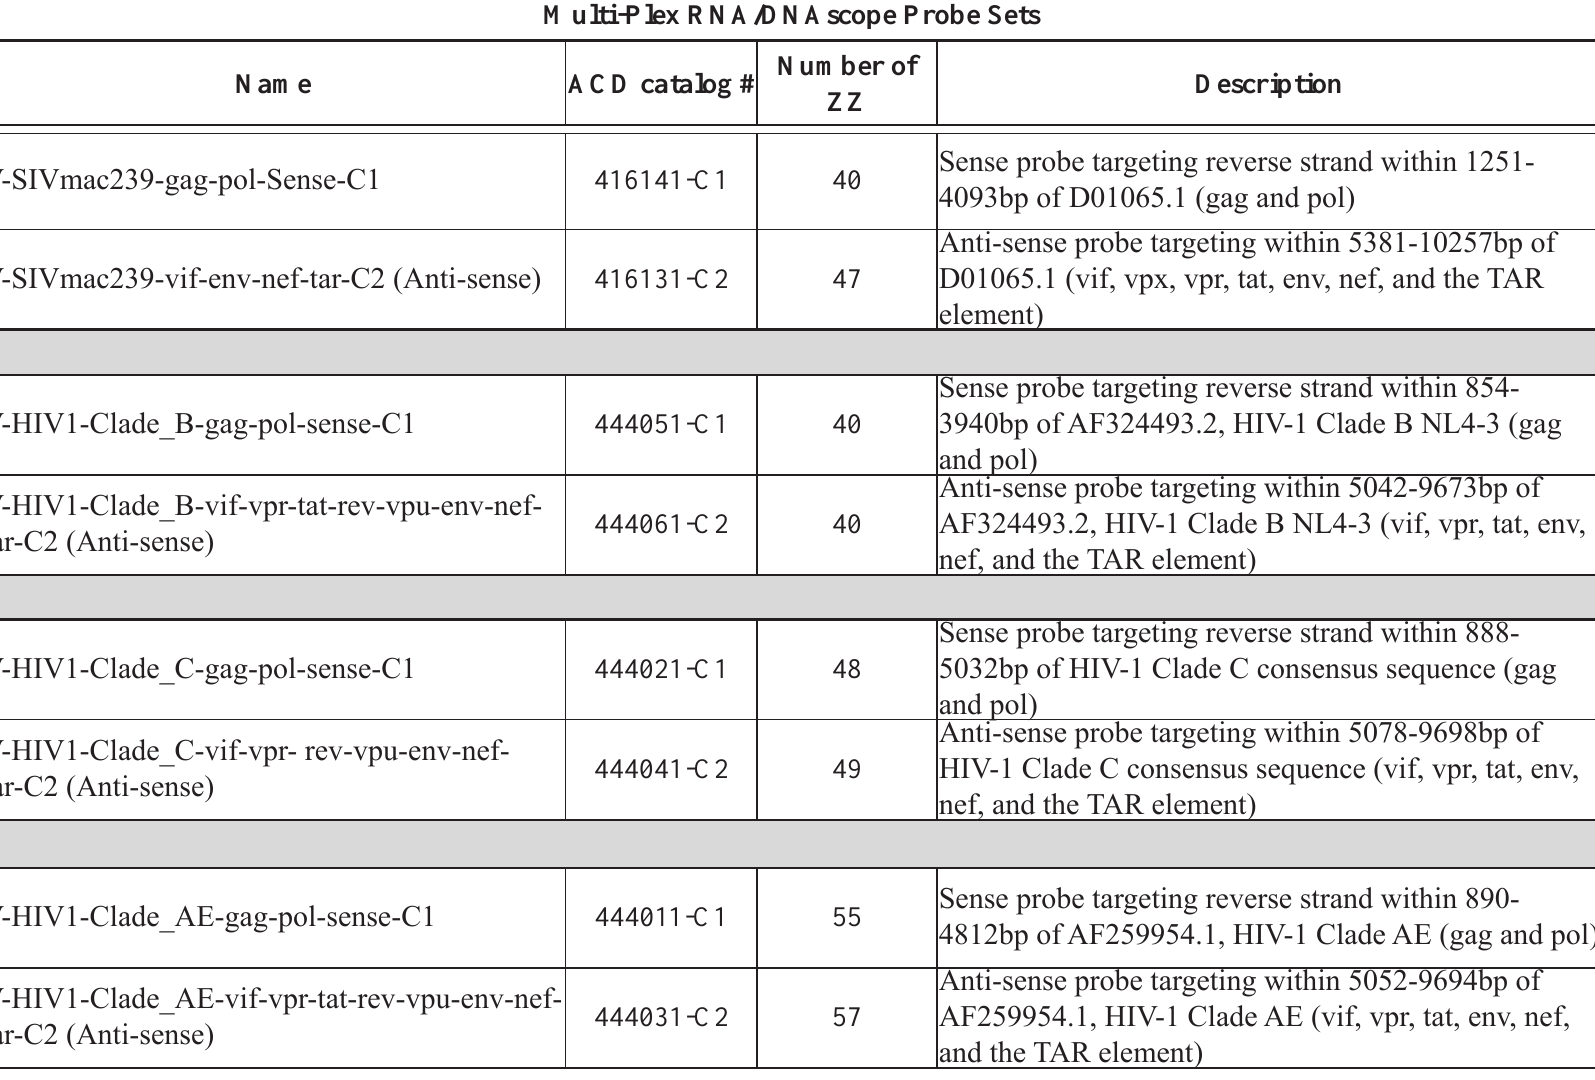
Supplemental Table 3 . Duplex RNAscope and DNAscope probes Multi-Plex RNA/DNAscope Probe